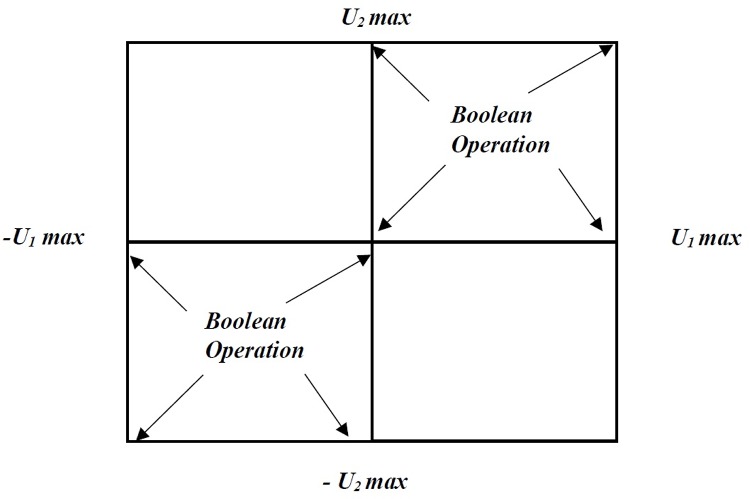
Input Structure.